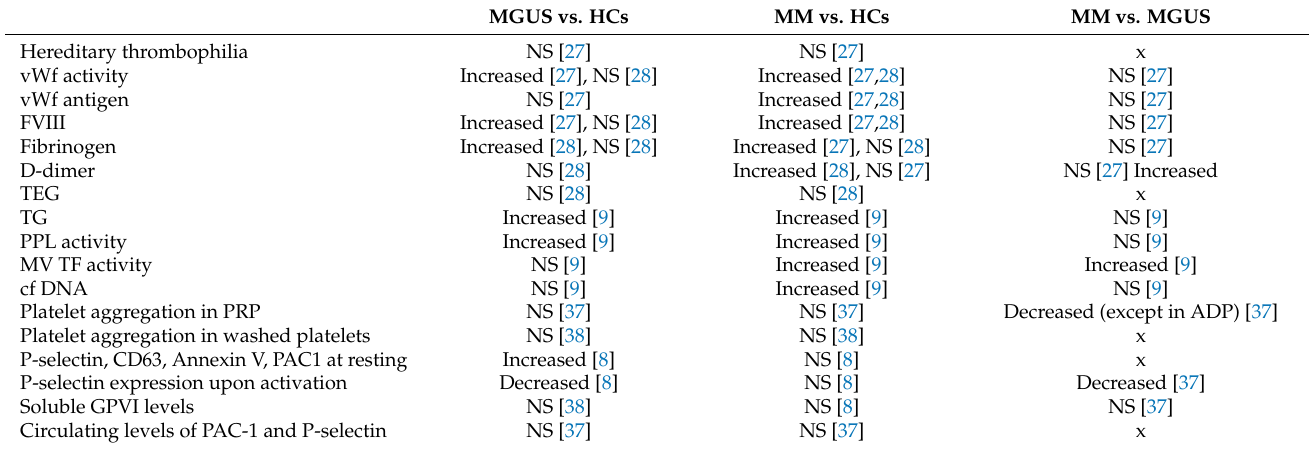
Table 3. Comparison of coagulation biomarkers between patients with Monoclonal gammopathy of undetermined significance (MGUS), healthy controls (HC) and multiple myeloma patients (MM). All comparisons are statistically significant ( p < 0.05) unless otherwise stated, where NS: non-statistically significant differences between compared groups. Only data from studies thatinclude MGUS patients are shown in the table, x: no data reported, vWF: von-Willebrand factor, TEG: